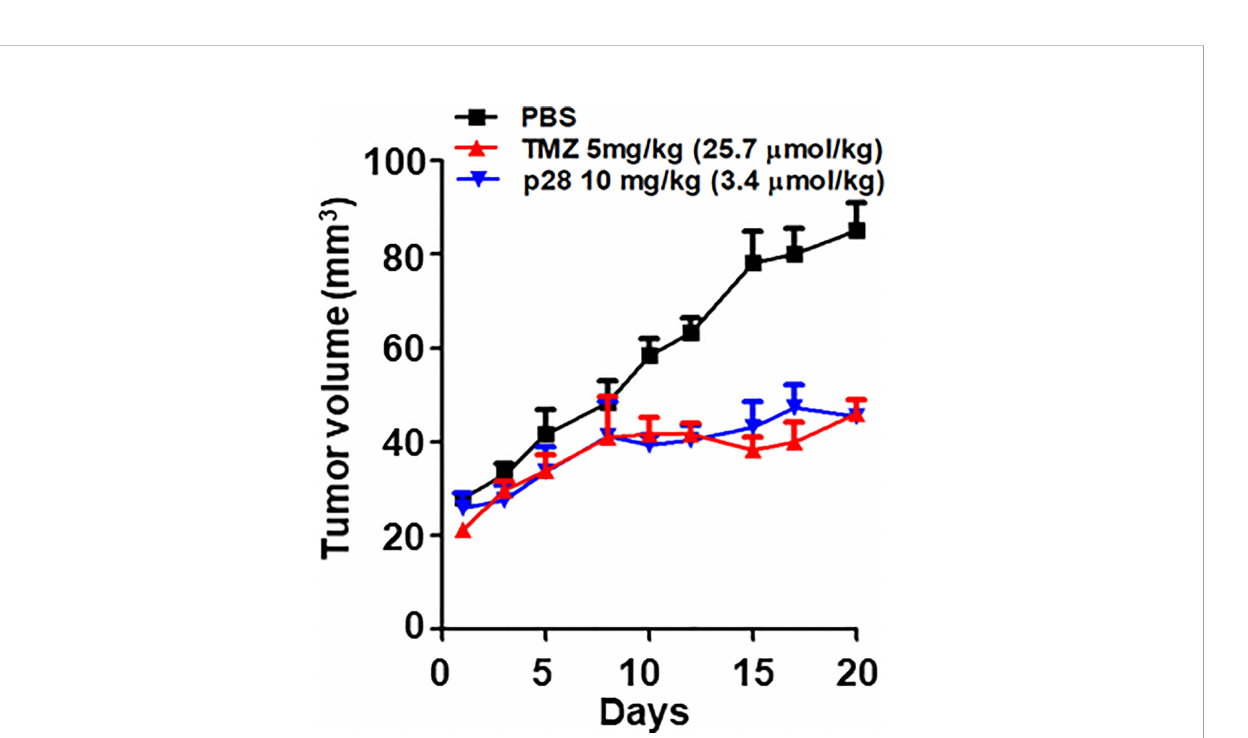
FIGURE 5 Antitumor effect of TMZ alone and p28 alone in a xenograft tumor model. Athymic mice bearing human GBM LN-229 cells were randomized into three groups; PBS (control), TMZ 5 mg/kg (=25.7 m mol/kg), and p28 10 mg/kg (=3.4 m mol/kg) i.p. N=5/group, Mean+SD.